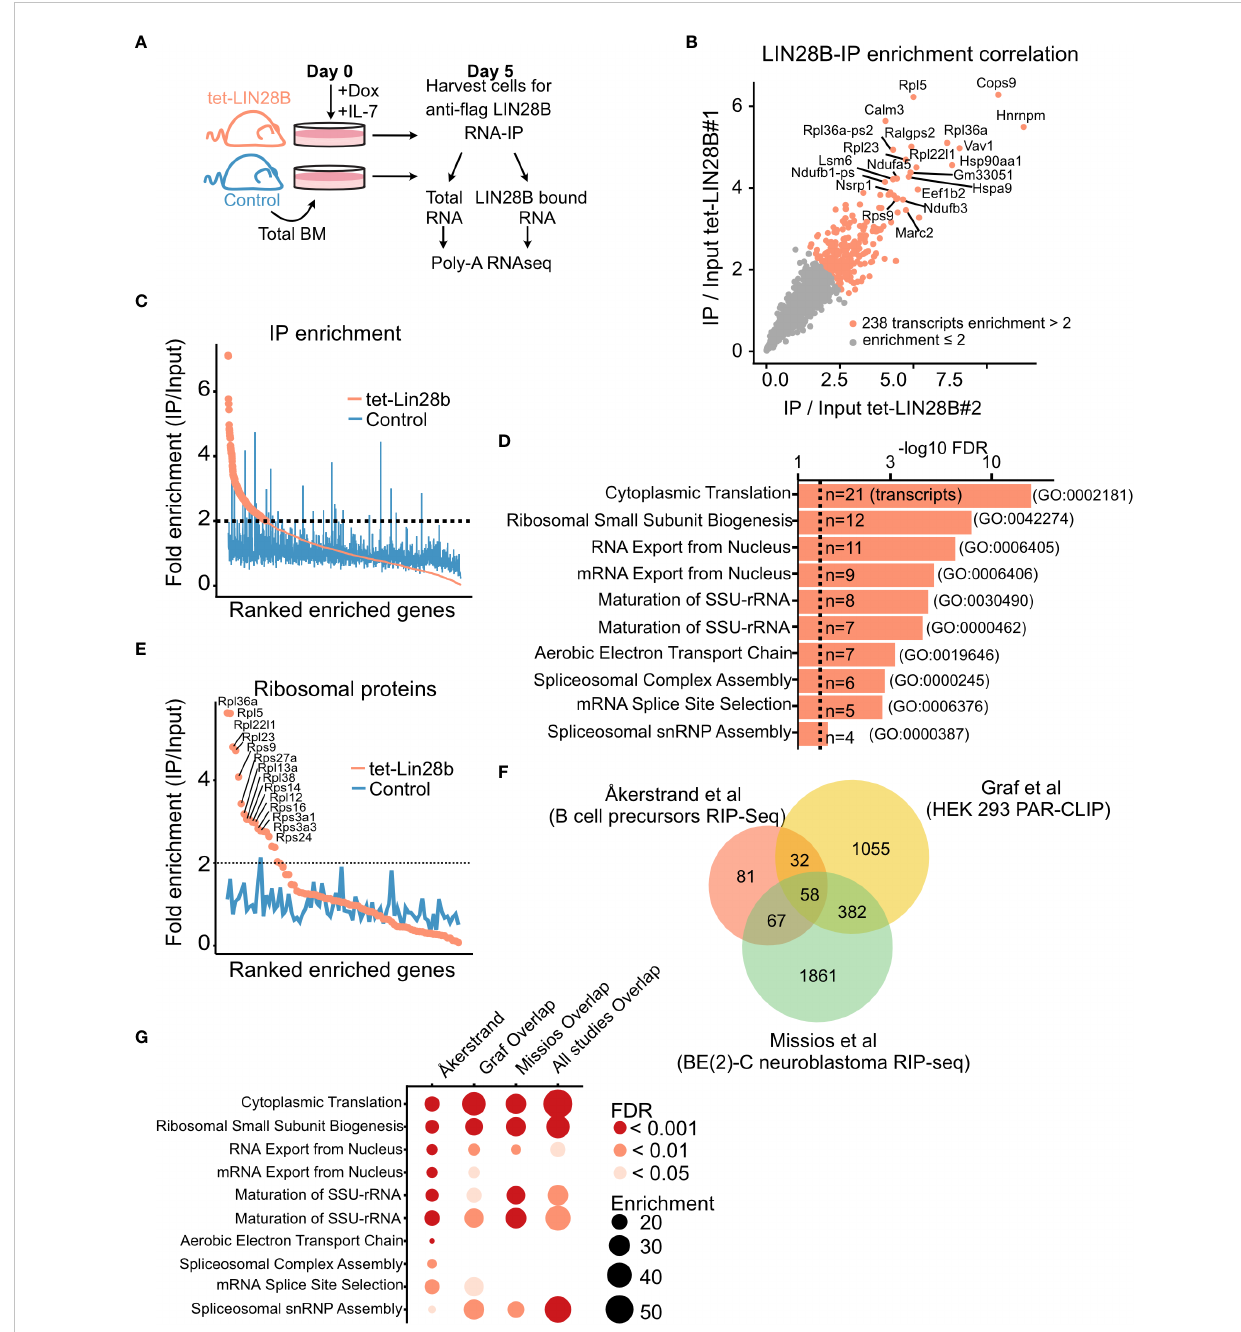
FIGURE 1 LIN28B binds to ribosomal protein transcripts in primary B cell precursors. (A) Schematic of experimental setup for the identi fi cation of LIN28B- bound mRNA targets in bone marrow (BM) B cell precursors. Uninduced adult total BM of the indicated genotypes were plated in IL-7 (20 ng/mL) and Doxycycline (Dox, 0.1 µg/mL) prior to RNA-IP for fi ve days to allow for Pro-B cell expansion. Co-immunoprecipitated mRNA from two tet- LIN28B and one control mouse were individually subjected to Poly-A RNA-seq. (B) IP/input enrichment ratios from the two tet-LIN28B samples were plotted against each other showing high correlation between the two biological replicates. LIN28B IP/input enrichment ratio of greater than two-fold (n=238 transcripts) were used for subsequent analyses. (C) Average enrichment ratio ranking of the two tet-LIN28B samples compared to control. (D) Top ten gene ontology terms of the 238 enriched transcripts. (E) Graph showing the average enrichment ratio of all ribosomal protein coding transcripts ranked by IP/Input. (F) Analysis of overlapping genes between the 238 LIN28B enriched transcripts of this study (Åkerstrand et al) and previously published LIN28B-mRNA RIP-Seq and PAR-CLIP data sets (22, 31). (G) Gene ontology analyses of overlapping interacting transcripts between the indicated